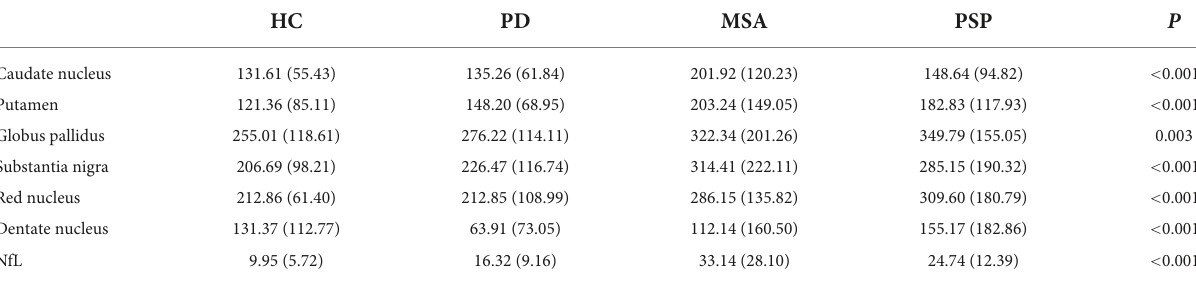
TABLE 2 Comparison of susceptibility values of all ROIs (ppb) and serum NfL levels (pg/ml) in HC, PD, MSA, and PSP.